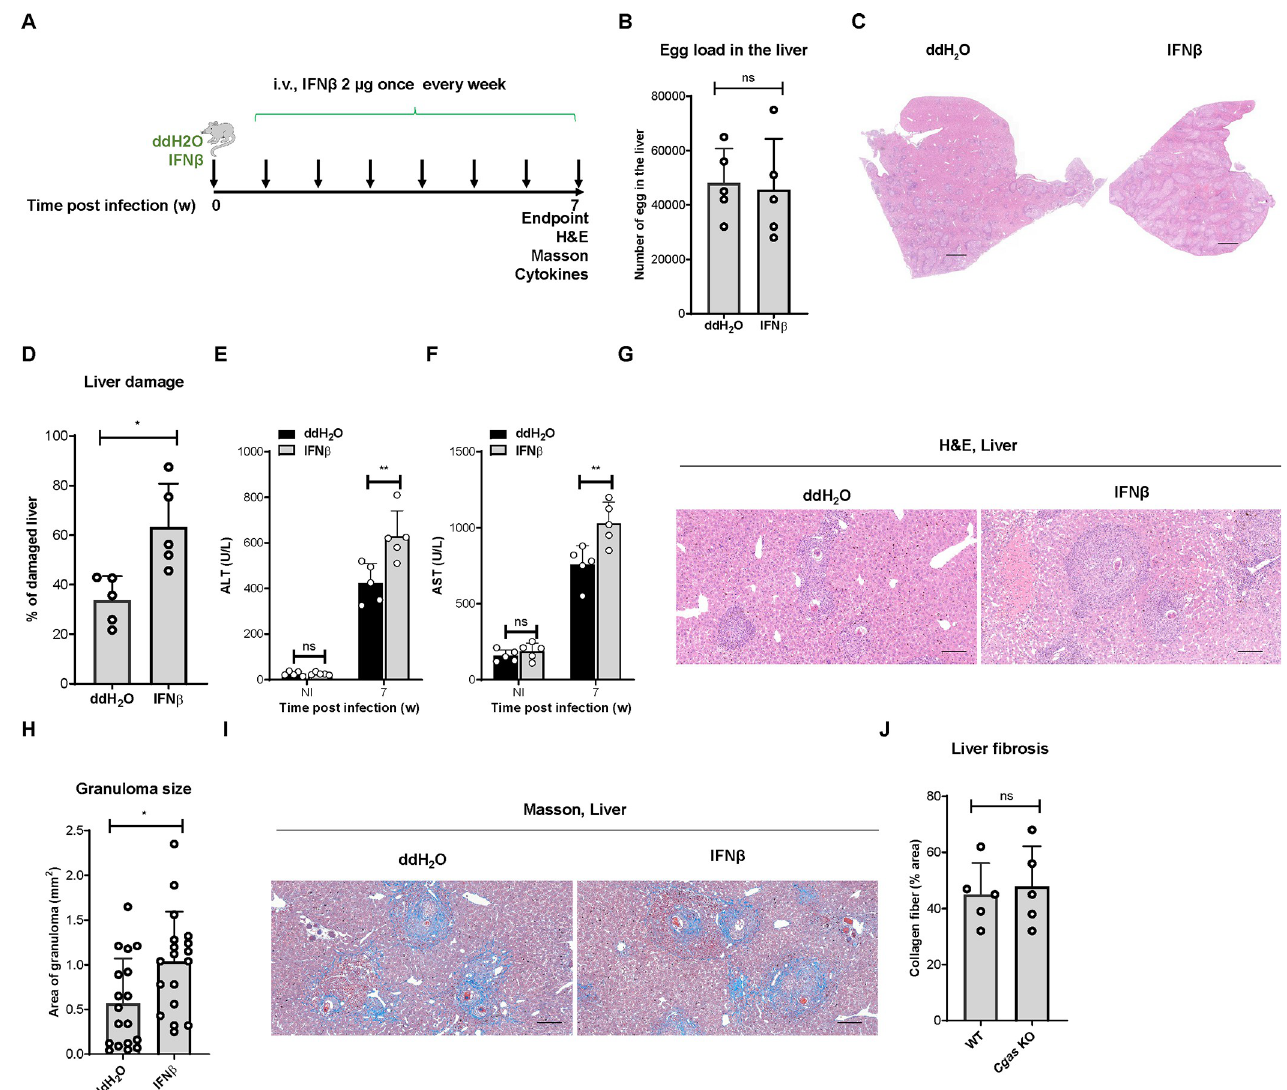
Fig 4. IFN β exacerbates Schistosoma japonicum infection in mice. (A) Schematic diagram showing the experimental procedure for the tail vein injection of phosphate-buffered saline (PBS) control and 2 μ g of recombinant interferon beta once a week for 7 weeks in mice infected with S . japonicum . The liver tissues were harvested for further experiments. (B) The egg loads in the liver of mice infected with S . japonicum left untreated or treated with interferon beta. Data are expressed as the mean ± SD of the indicated number of mice from one of three independent experiments. (C-D) Representative images showing liver damage in mice infected with S . japonicum left untreated or treated with interferon beta. Scale bar, 1 000 μ m. The quantification of the liver damage is shown in D. Data are expressed as the mean ± SD of the indicated number of mice from one of three independent experiments. (E-F) Measurement of the level of ALT (E) and AST (F) in the sera of mice infected with S . japonicum left untreated or treated with interferon beta by tail vein injection. Data are expressed as the mean ± SD of the indicated number of mice from one of three independent experiments. (G-H) Representative imaging showing egg-induced granulomas in the livers of mice infected with S . japonicum left untreated or treated with interferon beta by tail vein injection. Scale bar, 200 μ m. The quantification of the area of the granulomas is shown in (H). Data are expressed as the mean ± SD of indicated number of granulomas of mice from one of three independent experiments. (I-J) Representative images showing Masson staining of the fibrosis in the liver of mice infected with S . japonicum left untreated or treated with interferon beta. Scale bar, 200 μ m. The quantification of the area of fibrosis is shown in (J). Data are expressed as the mean ± SD of the indicated number of mice from one of three independent experiments. An unpaired Student’s t-test was used for the statistical analysis in (B, D, H and J). Two-way ANOVA with Bonferroni’s post hoc test was used for the statistical analysis in (E and F). ns, not significant; � , p < 0.05; �� , p < 0.01.